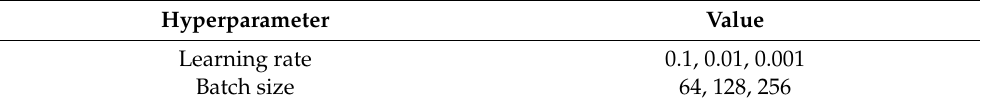
Table 6. Hyperparameters for the recurrent neural network grid